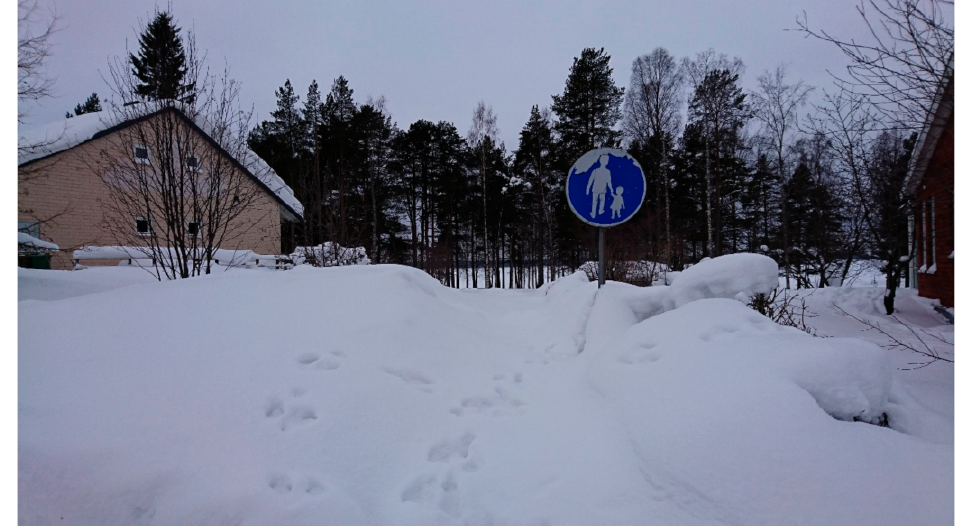
Figure 3. A participant’s photograph shows how walkways can ‘disappear’ in the winter season.